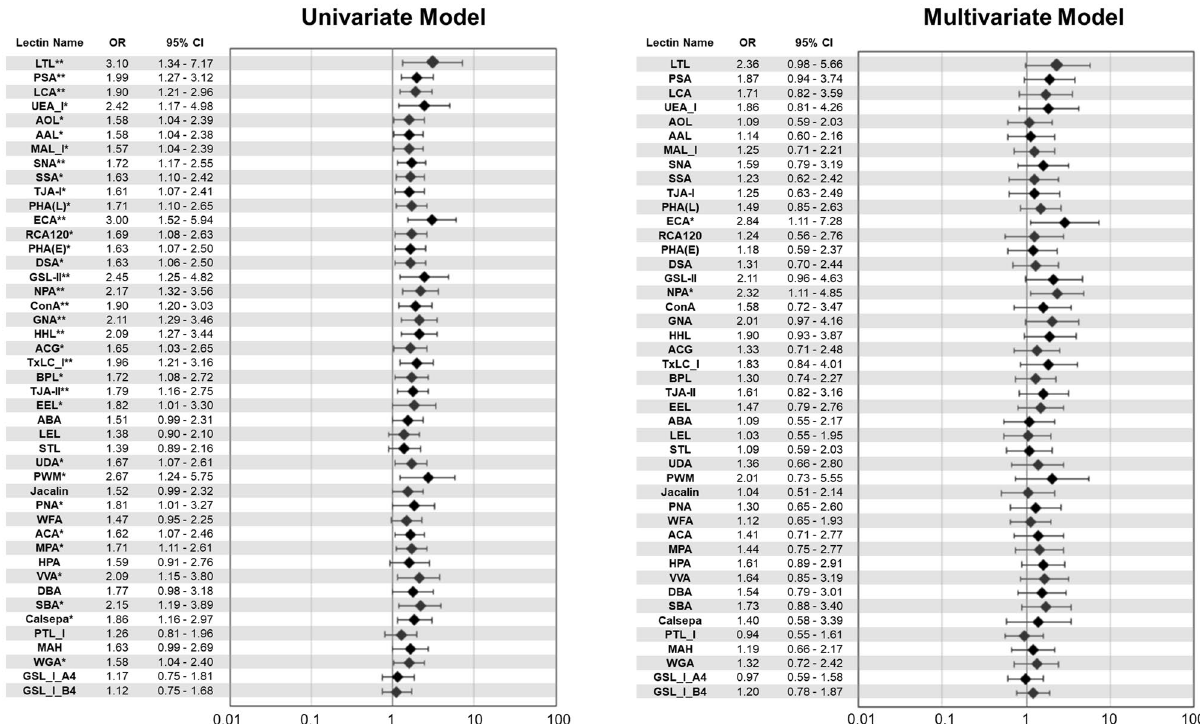
Figure 1. Univariate and multivariate logistic regression models for the renal outcome predicted by glycan indexes of 45 lectins. In the multivariate model, the OR for 1 SD of the net glycan intensity was adjusted for age, sex, eGFR, and log-transformed 24-h urinary protein at baseline. * P < 0.05, ** P < 0.01. Abbreviations: OR, odds ratio; 95% CI, 95% confidence interval; eGFR, estimated glomerular filtration rate. (StataCorp. 2015. Stata Statistical Software: Release 14. College Station, TX: StataCorp LP)